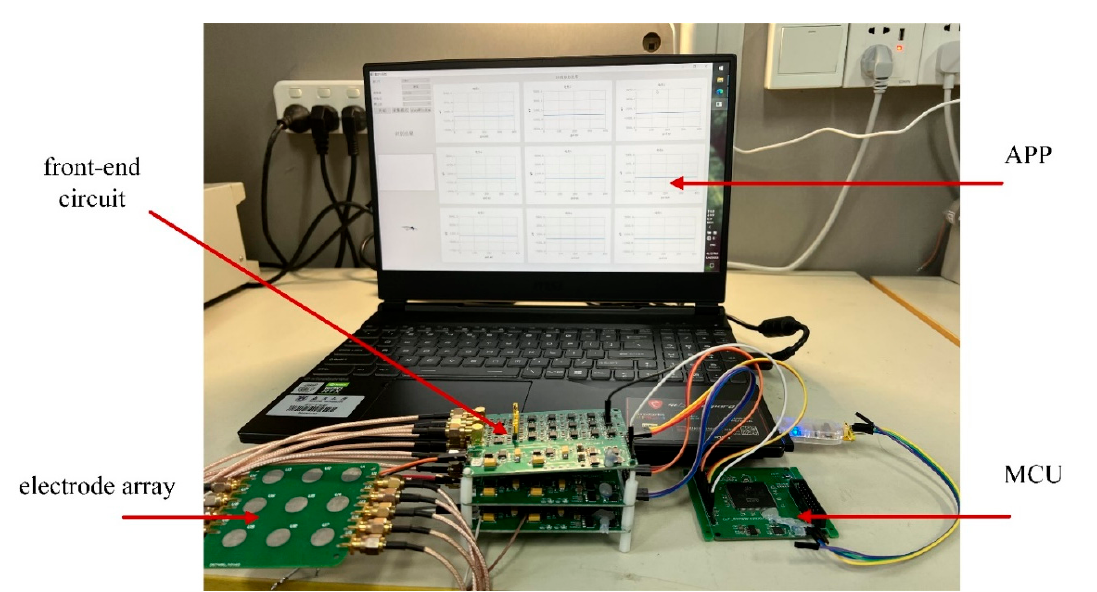
Figure 2. System device.